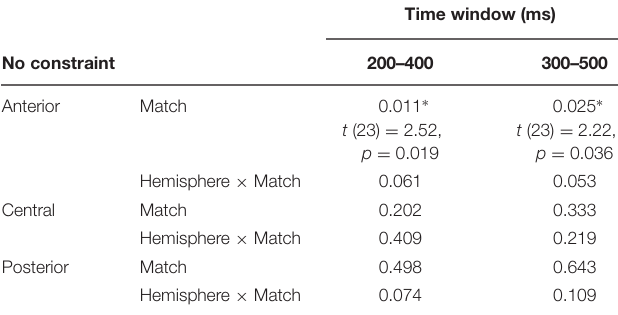
TABLE 3 | Simple comparisons “No Constraint”